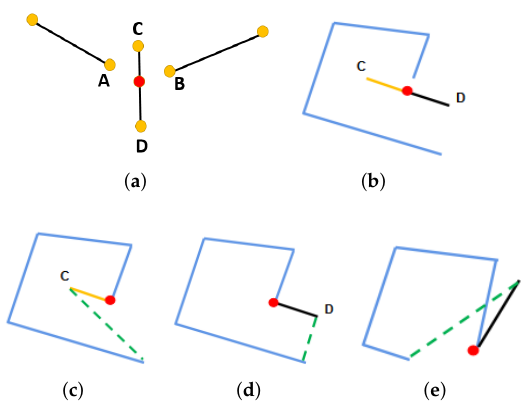
Figure 5. Corner selection. The red point is the corner obtained by calculation. The green dotted line is the boundary obtained after subsequent boundary prediction. ( a ) An example of potential intersection . ( b ) A potential intersection in a set of boundaries. ( c ) Let D to perform corner calculation. ( d ) Let C to perform corner calculation. ( e ) A wrong boundary prediction result.